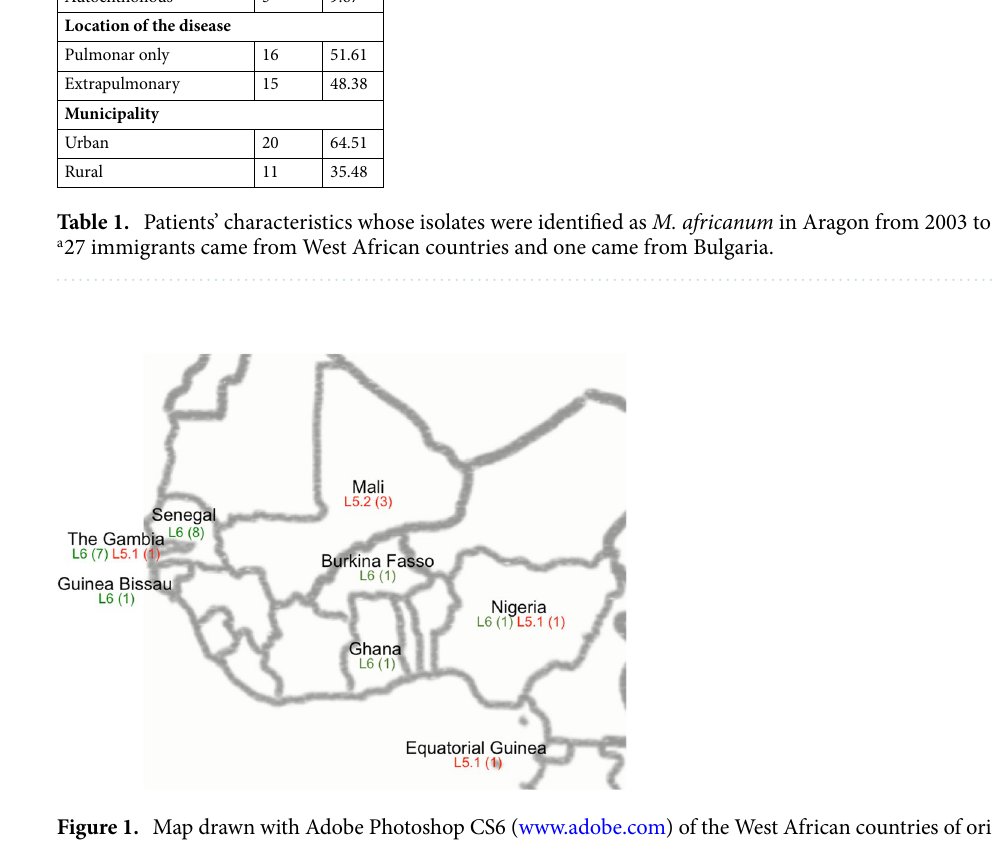
Figure 1. Map drawn with Adobe Photoshop CS6 (www. adobe. com) of the West African countries of origin for 26 of the cases. African countries where the patients came from are marked. The red colour indicates an L5 case of TB, and the green colour an L6 case. The number of cases is presented in